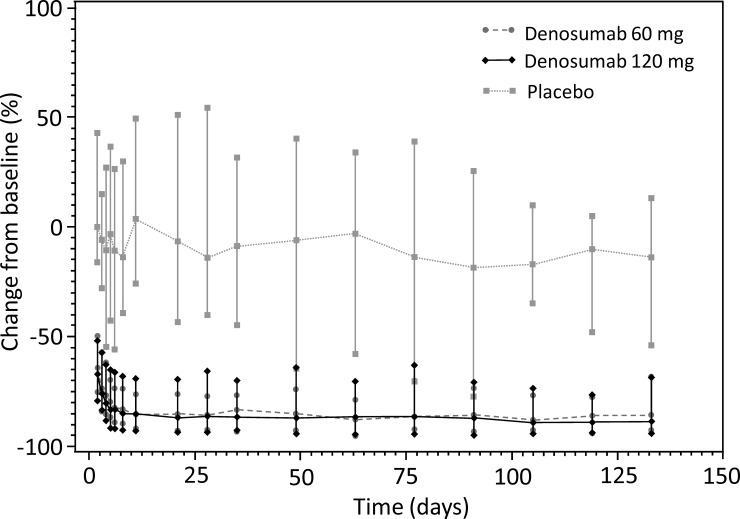
Change from baseline in median serum CTX1.Error bar represents range. CTX1, C-terminal cross-linking telopeptide of type I collagen.